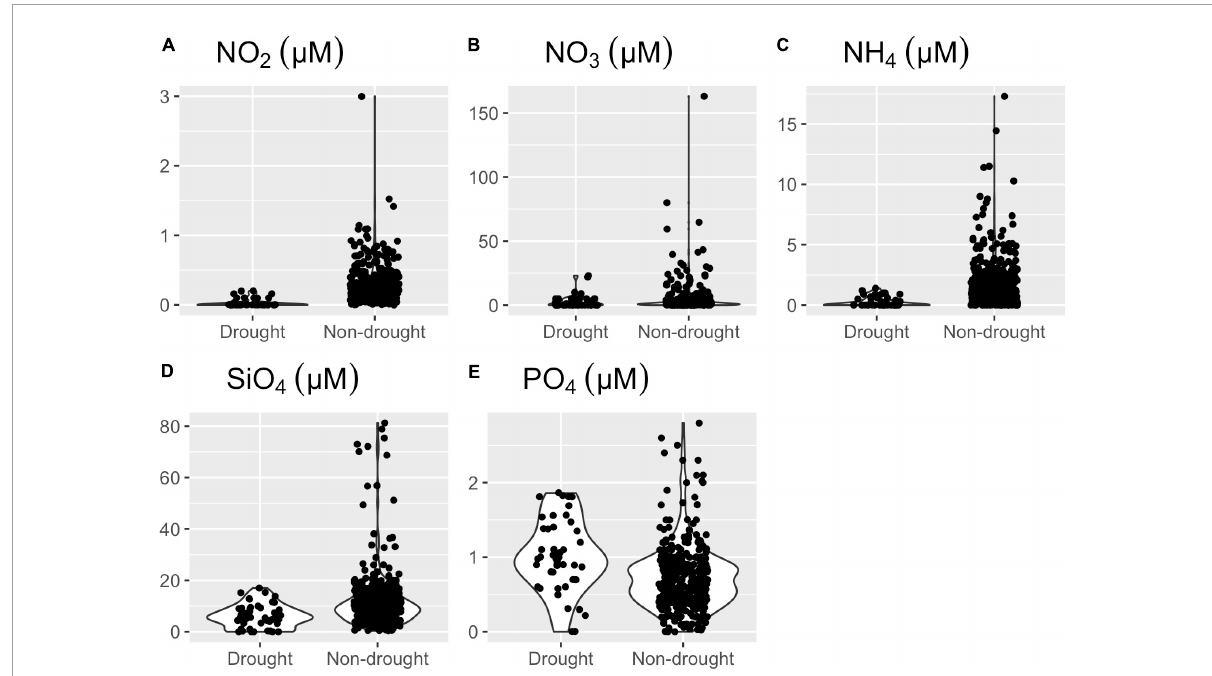
FIGURE5 Violin plots of nutrient concentrations in micromolar ( µ M) comparing drought conditions (October 2004 – May 2005) to non-drought conditions (remaining data 1987–2012), showing the median, 95, 75, 25, and 5 percentiles for: (A) nitrite (NO 2 ); (B) nitrate (NO 3 ); (C) ammonia (NH 4 ); (D) silicate (SiO 4 ); and (E) orthophosphate (PO 4 ). Raw data are shown as black dots.